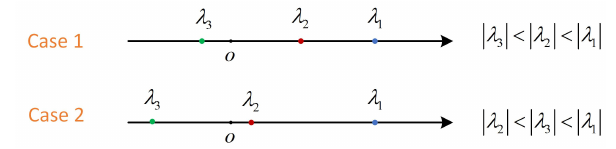
Figure 3. The different sorting cases of